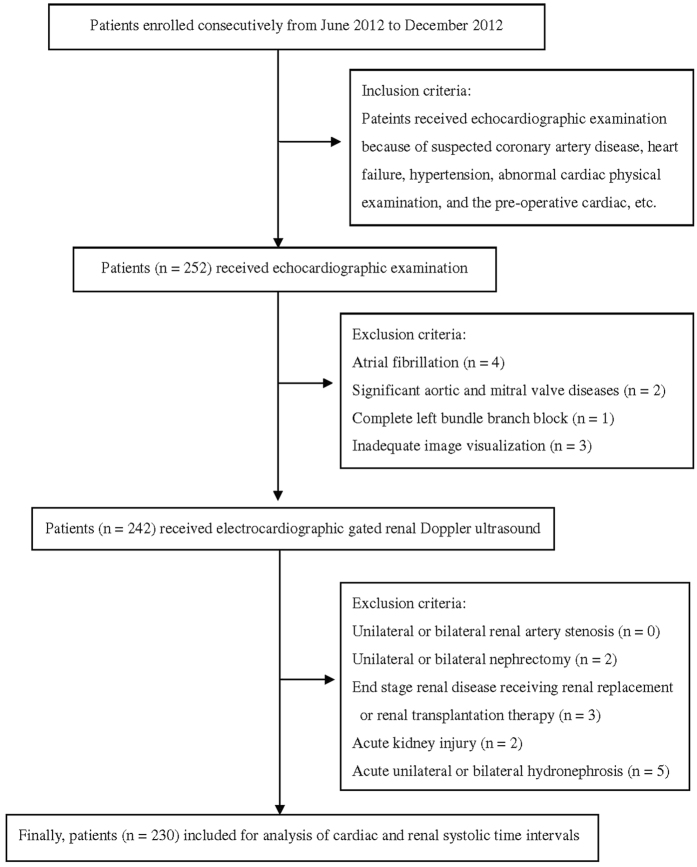
Flow chart of study patients.